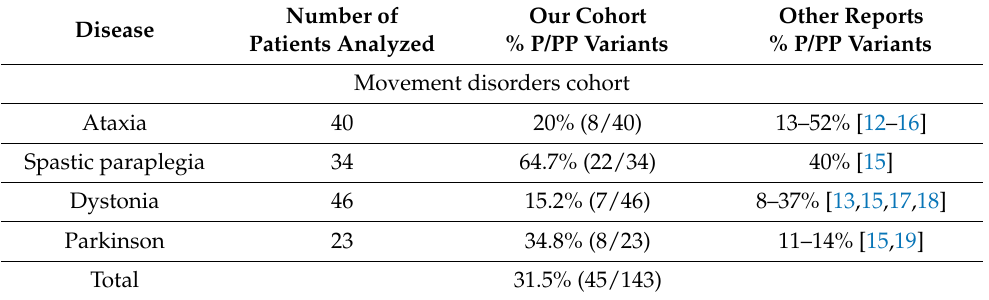
Figure 1. Diagnostic rate of WES in patients with various neurological diseases. Blue bars indicate the percentage of cases in which a pathogenic variant has been detected; red bars indicate cases in which a VUS has been detected; and green bars indicate cases in which no responsible variant has been detected. Table 2. Diagnostic yield in our cohort and other studies in patients with different neurological